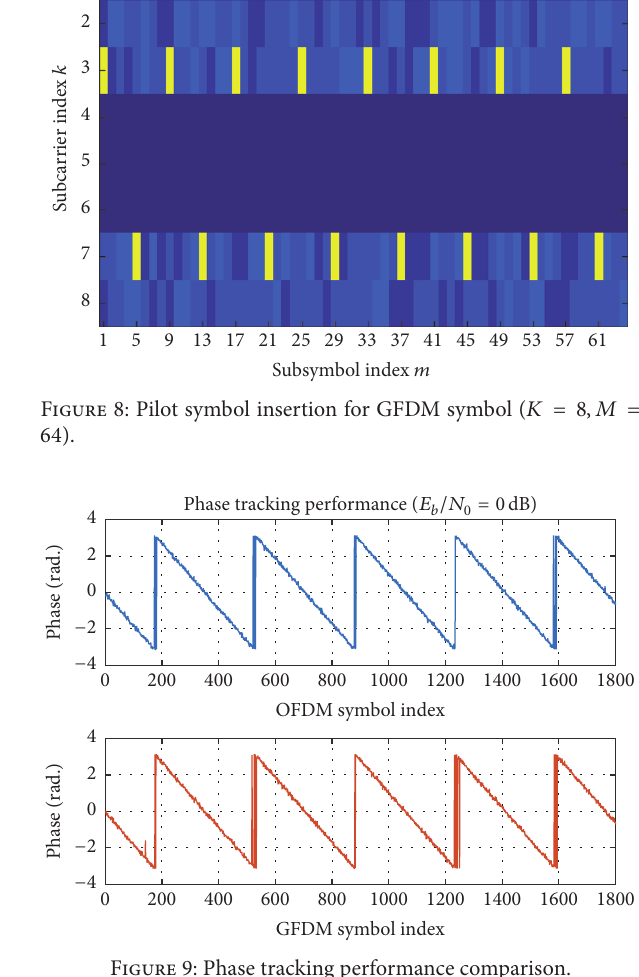
Figure 9: Phase tracking performance